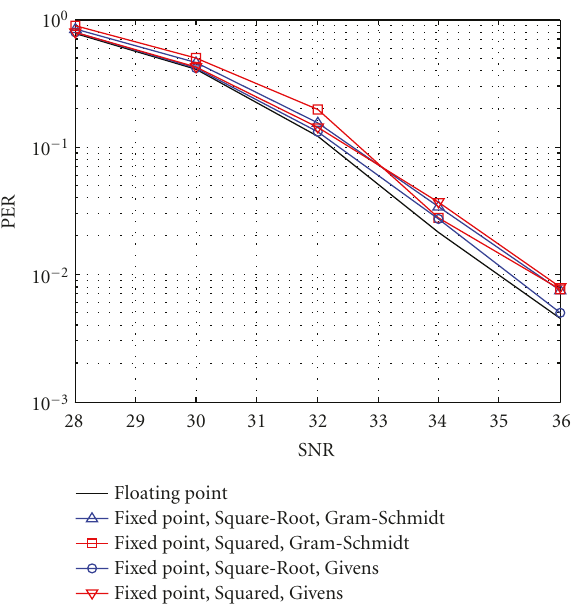
Figure 3: PER Performance of fixed point algorithms, 4 × 4 64 QAM.